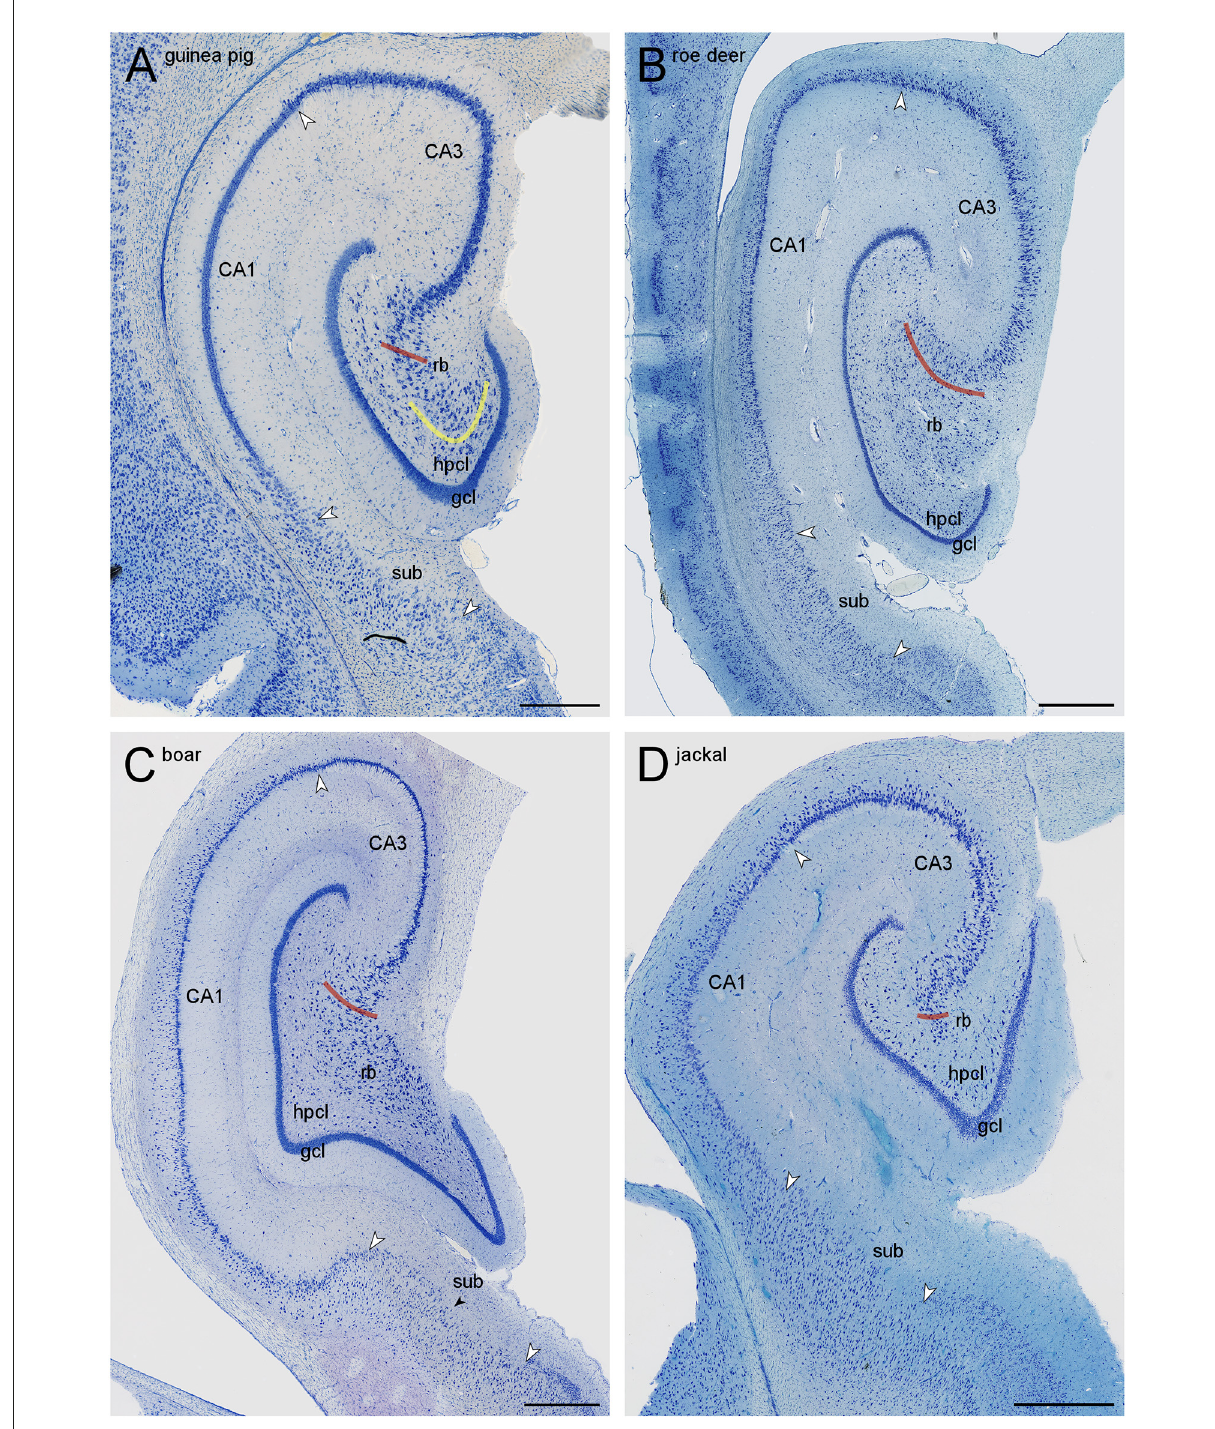
FIGURE2 Mid-septotemporal sections of the hippocampal formations of guinea pig (A) , European roe deer (B) , wild boar (C) , and golden jackal (D) . Red lines mark the border of the CA3 reflected blade (rb) towards the remainder of CA3. Yellow lines mark the boundary between the reflected blade and the hilar polymorphic cell layer (hpcl) in species in which they partially merge. Large white arrowheads mark regional borders. The small black arrow in (C) marks the approximate boundary between the proximal subiculum (or prosubiculum) and the distal subiculum. In all species, the size of the reflected blade decreases towards the temporal pole of the hippocampus. The decrease is, in our species sample, most pronounced in the jackal, and only little of the reflected blade remains in the mid-septotemporal jackal hippocampus. Scale bars: (A) 0.5 mm; (B,C) and (D) 1